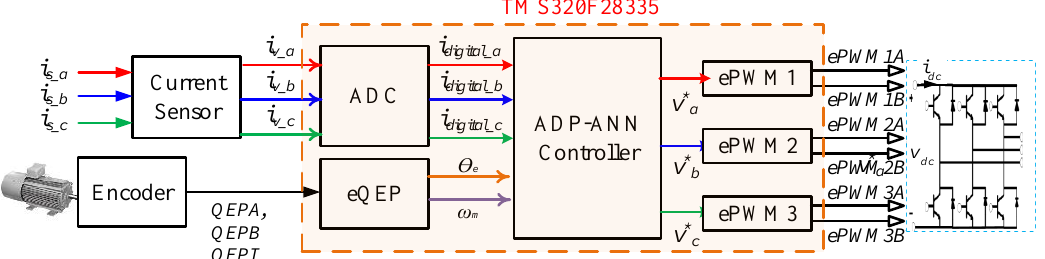
Figure 8. Hardware structure of the DSP-based NN control system.